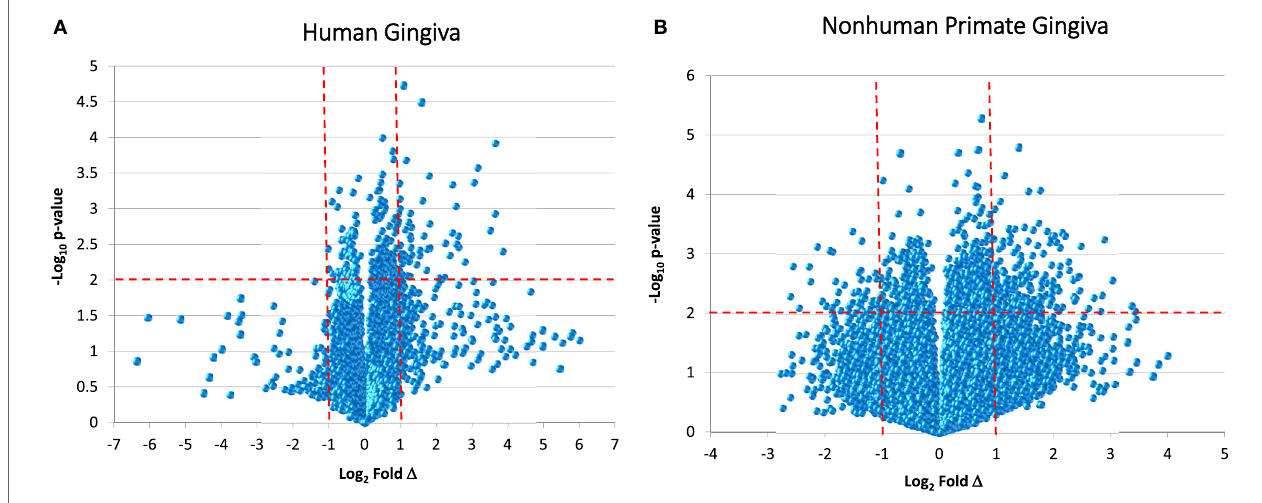
FigUre 1 | Volcano plots of gene expression in human gingival tissues (a) and non-human primate gingival tissues (B) comparing levels in periodontitis tissues from healthy tissues . Human samples ( n = 3 healthy; n = 4 periodontitis) and non-human primate samples [ n = 13 healthy; n = 11 periodontitis (adults and aged)] were tested. The graphs displays a point for the expression of each gene in periodontitis versus healthy tissues plotted as log 2 fold difference ( Δ ) and − log 10 p -value significance versus healthy tissues. The vertical red dashed lines signify a fold difference in expression at twofold and the horizontal red dashed line signifies a significant difference of p <